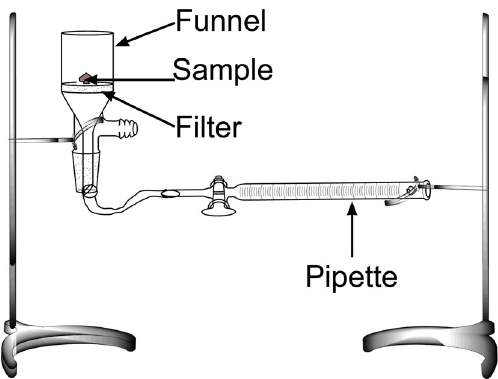
Figure 2. Image of the setup used for the water imbibing capacity tests.